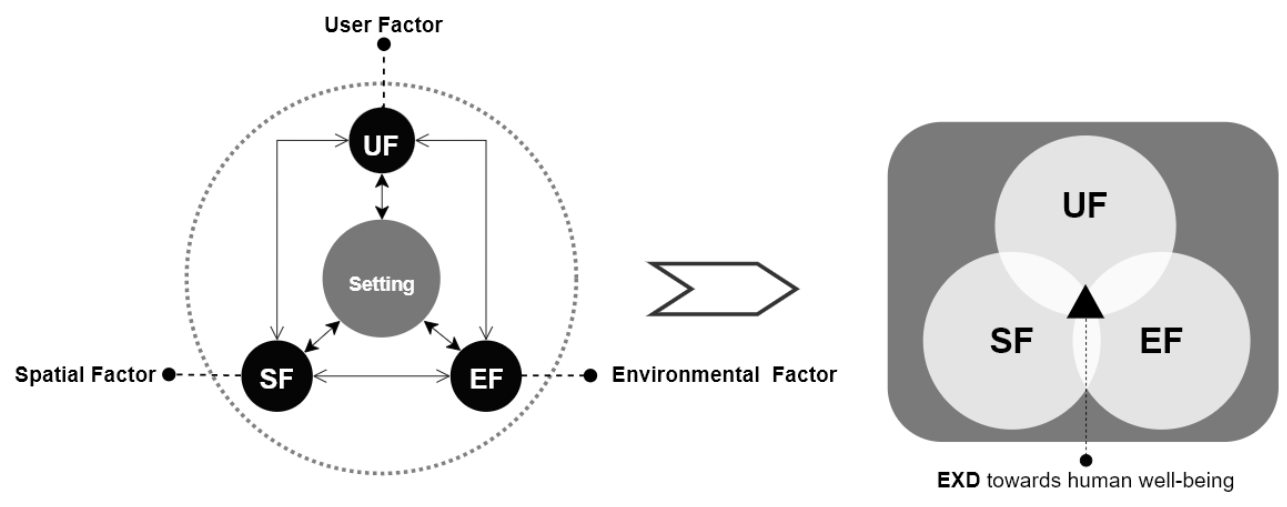
Figure 7. Research hypothetical construct (source: author).